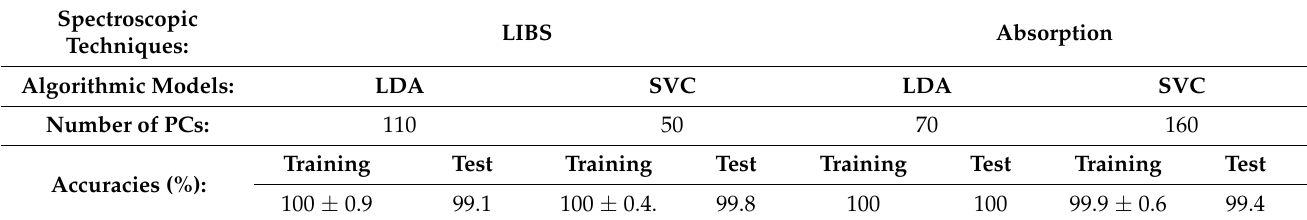
Table 5. Summary of the algorithmic